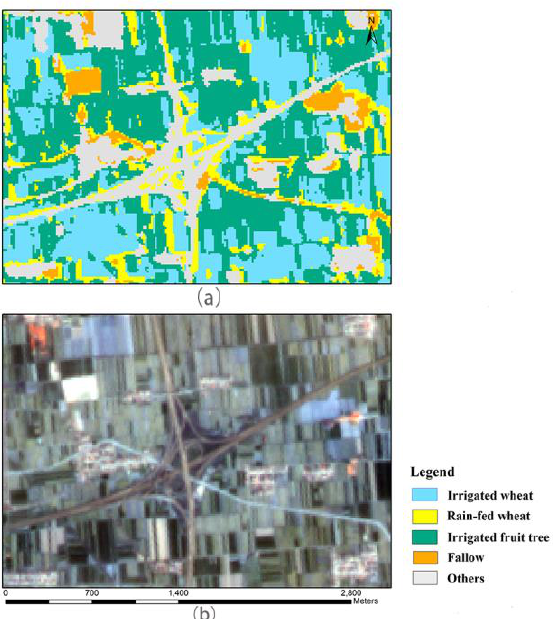
Figure 5. Comparison of the partial enlarged details in the (a) cropland map during winter-spring irrigation period of 2018 and (b) the satellite image on March 29, 2018